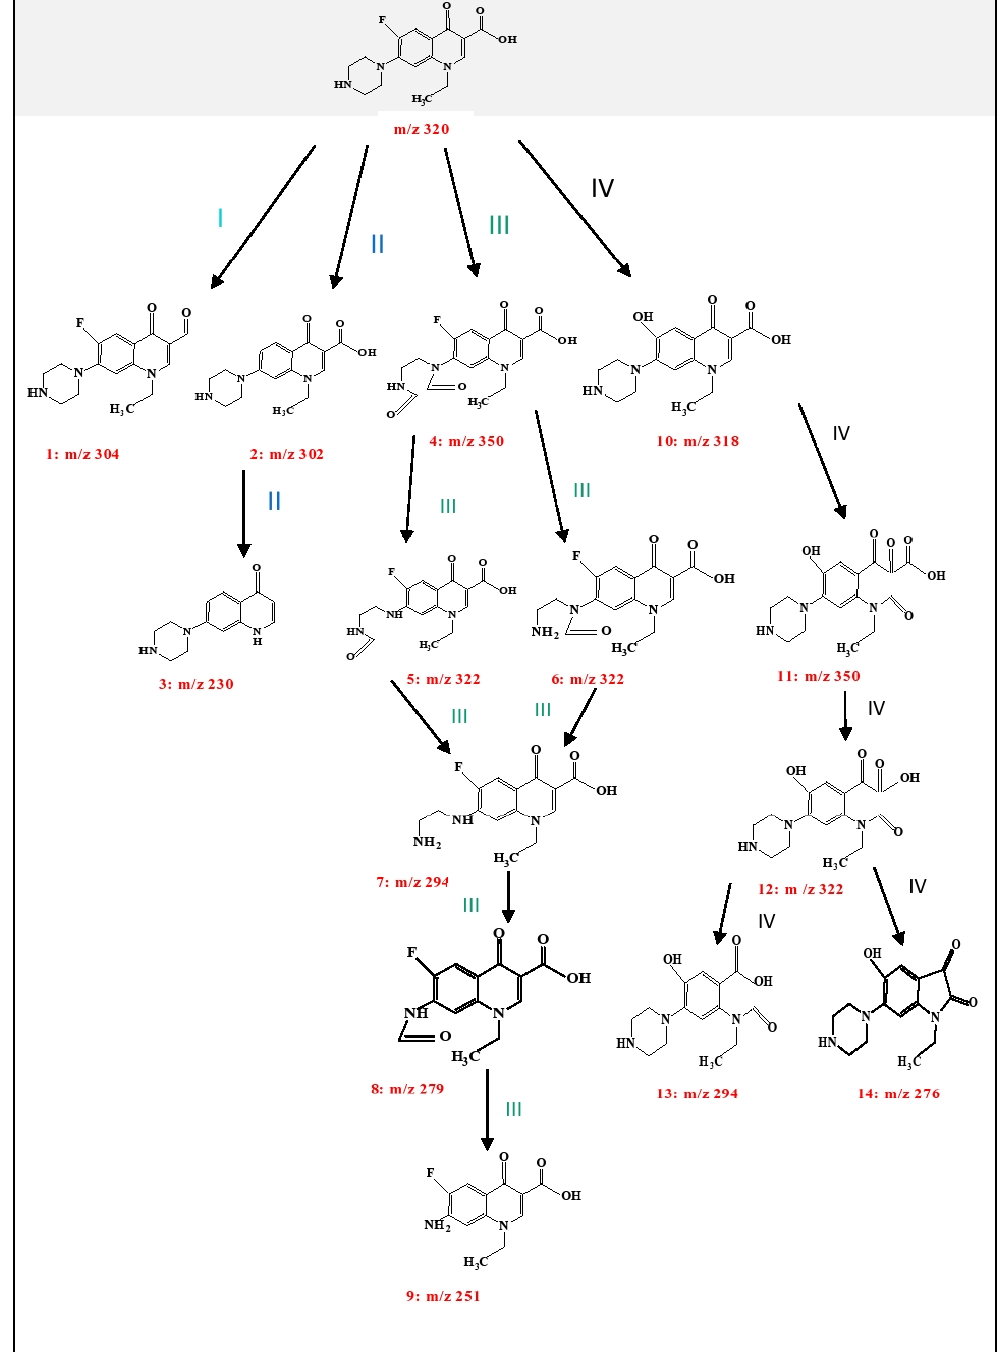
Figure 19. Probable photocatalytic degradation pathway of NOFX.